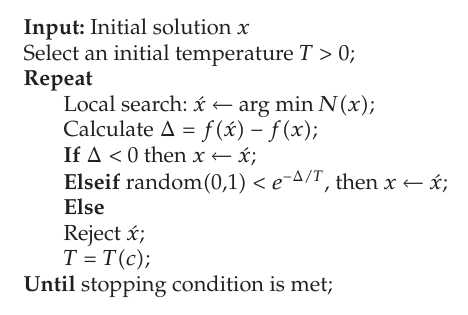
Algorithm 3: The outline of simulated annealing.